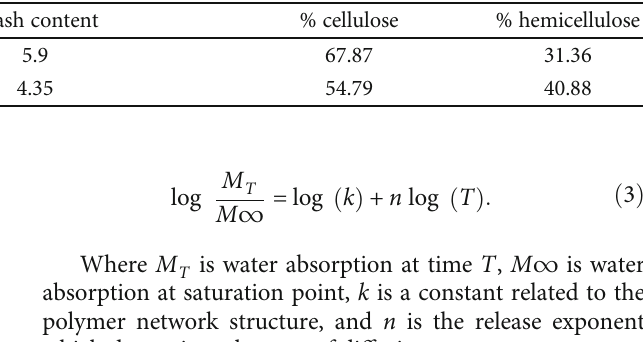
Table 2: Fiber constituents after chemical